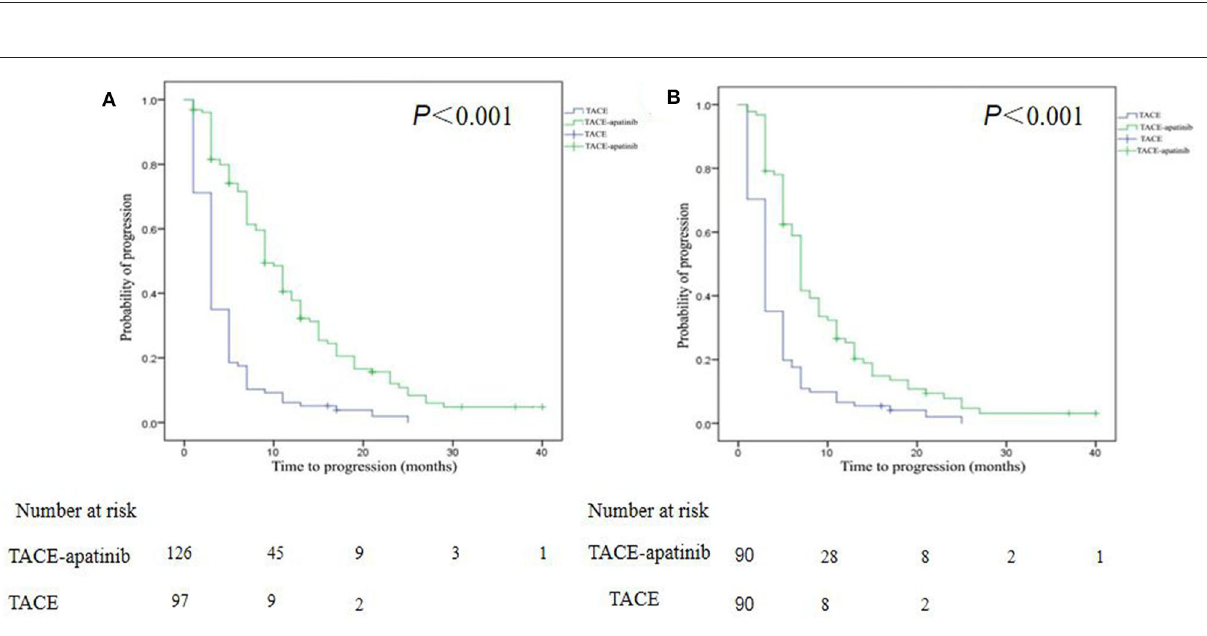
Frontiers in Oncology |